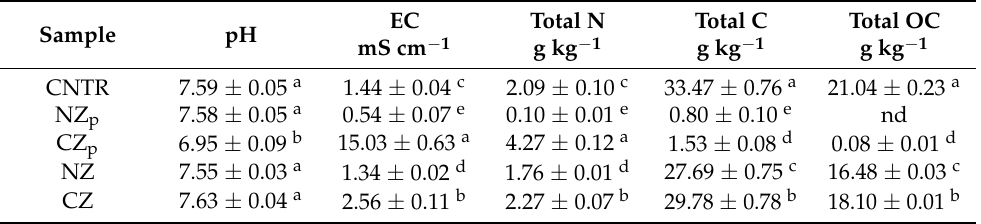
Table 1. Basic zeolites and soil properties. NZ p and CZ p refer to pristine chabazite zeolite tuff (with no soil added) in natural and NH 4+ -enriched state, CNTR is the unamended soil, NZ is the soil + 10% wt of NZ p while CZ is the soil amended with 10 wt% of CZ p . EC is electrical conductivity (mS cm − 1 ). Values are expressed as mean ± standard deviation (3 replicates). Different